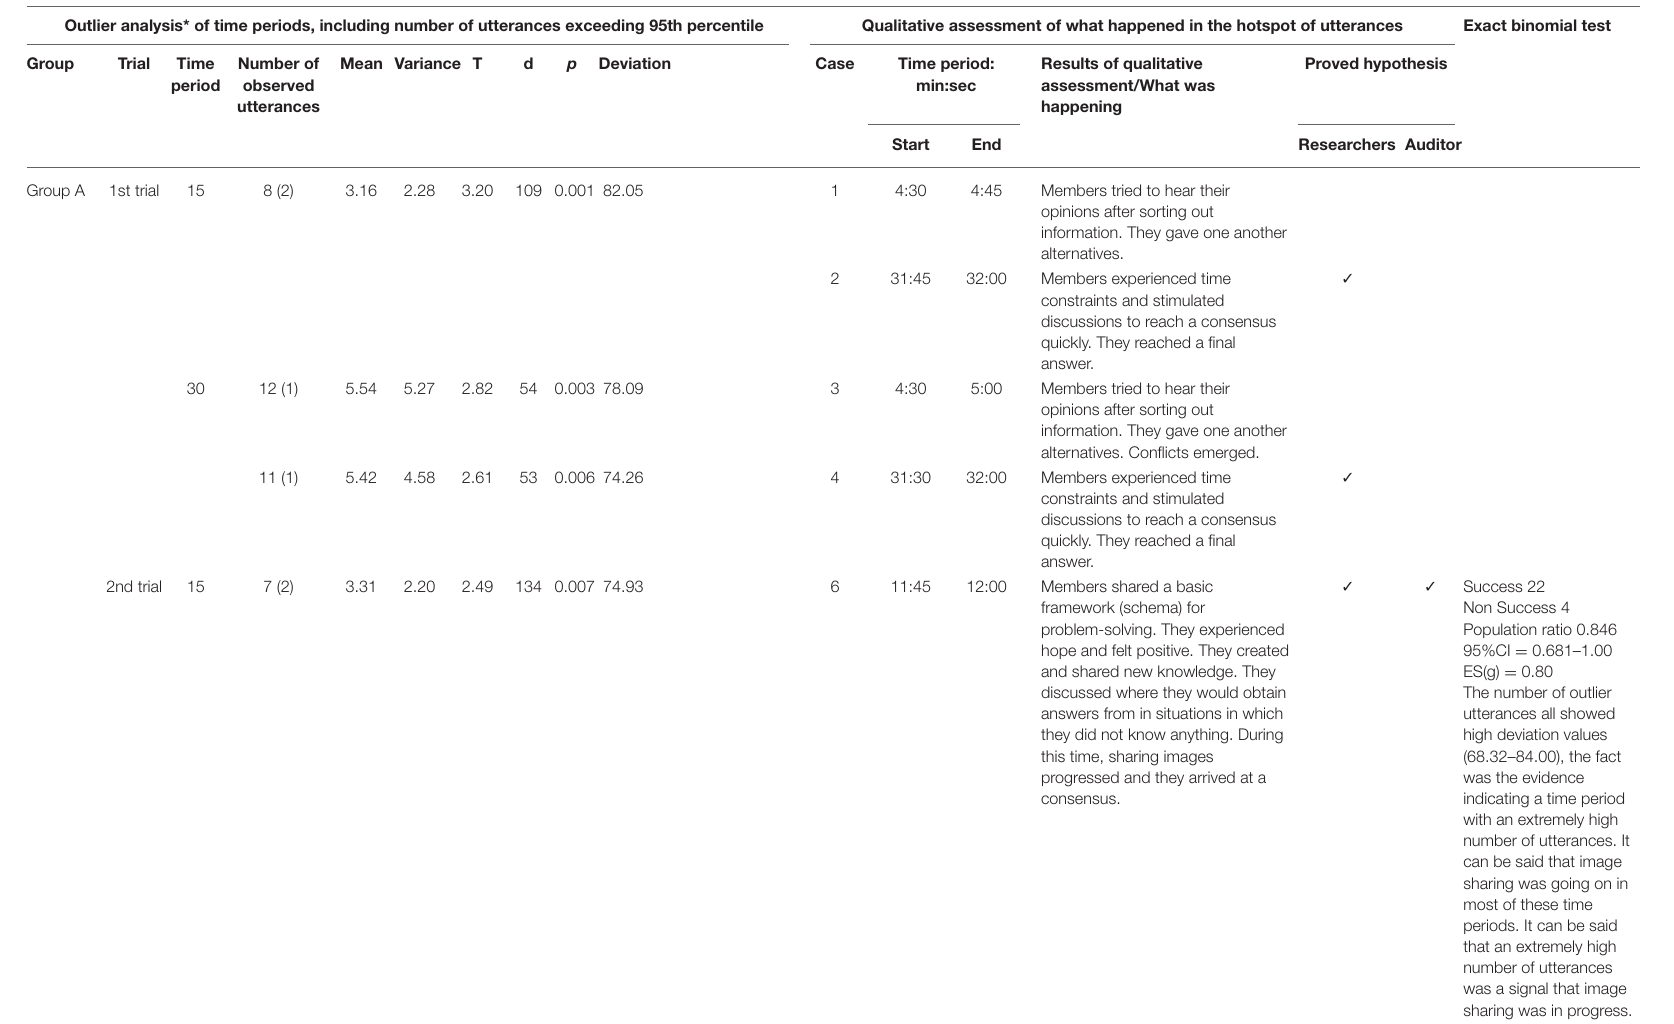
TABLE 3 | Joint display showing that a substantial number of utterances signaled the sharing of an image. Outlier analysis* of time periods, including number of utterances exceeding 95th percentile Qualitative assessment of what happened in the hotspot of utterances Exact binomial test